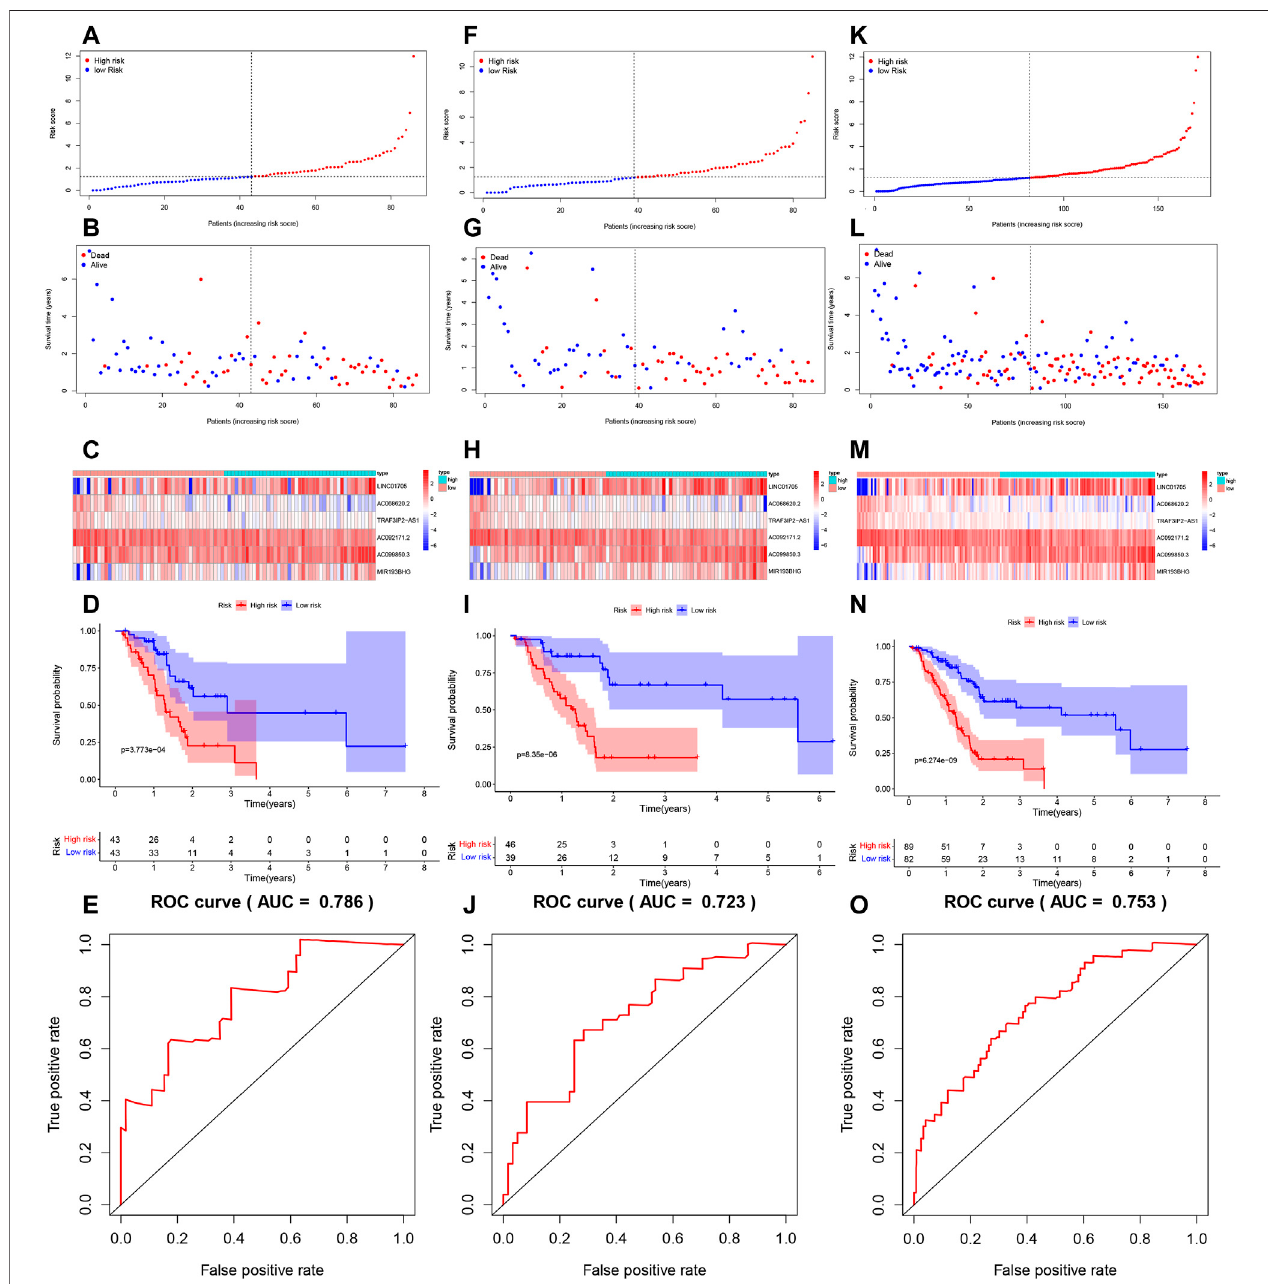
FIGURE 4 | Risk score model development and validation. (A) Trianing cohort risk score distribution of a patient with PAAD based on FRLs. (B) Trianing cohort scatter plots showing the association between the OS and the risk score in PAAD patients according to prognostic features of FRLs. (C) Trianing cohort heatmap showing three unfavorable genes (LINC01705, AC099850.3, and MIR193BHG) with high expression in high-risk patients, contray to the expression of the three favorable genes (AC068620.2, TRAF3IP2-AS1, and AC092171.2). (D) Trianing cohort KM survival curve analysis. (E) Testing cohort area under the ROC curve basedonFRLs-basedprognosticfeaturesat12 months. (F) TestingcohortriskscoredistributionofapatientwithPAADbasedonFRLs. (G) Testingcohortscatterplots showing the association between the OS and the risk score in PAAD patients according to prognostic features of FRLs. (H) Testing cohort heatmap showing three unfavorable genes (LINC01705, AC099850.3, and MIR193BHG) with high expression in high-risk patients, contray to the expression of the three favorable genes (AC068620.2, TRAF3IP2-AS1, and AC092171.2). (I) Testing cohort KM survival curve analysis. (J) Testing cohort area under the ROC curve based on FRLs-based prognostic features at 12 months. (K) Entire cohort risk score distribution of a patient with PAAD based on FRLs. (L) Entire cohort scatter plots showing the association betweentheOSandtheriskscoreinPAADpatientsaccordingtoprognosticfeaturesofFRLs. (M) Entirecohortheatmapshowingthreeunfavorablegenes(LINC01705, AC099850.3, and MIR193BHG) with high expression in high-risk patients, contray to the expression of the three favorable genes (AC068620.2, TRAF3IP2-AS1, and AC092171.2). (N) Entire cohort KM survival curve analysis. (O) Entire cohort area under the ROC curve based on FRLs-based prognostic features at 12 months.